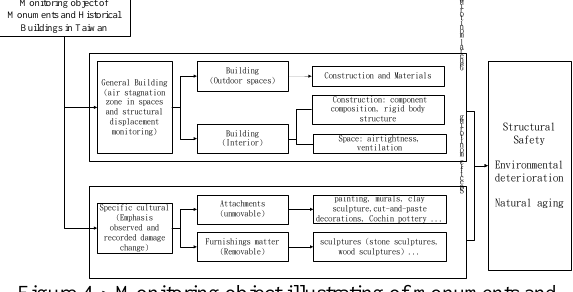
Figure 4 、 Monitoring object illustrating of monuments and historical buildings in